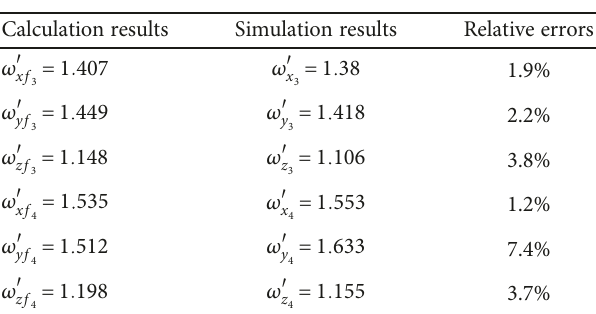
Table 23: Relative errors of calculation and simulation results for storage tank and microsatellite.